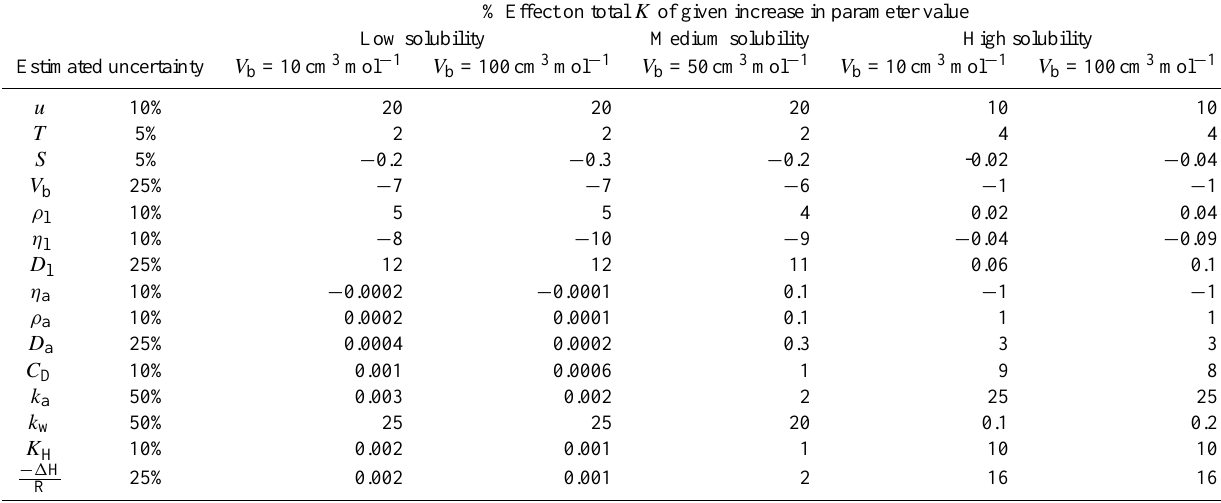
Table 5. Analysis of the sensitivity of total transfer velocity ( K ) to changes in the values of key components of the scheme. Note that the estimated uncertainty is intended to represent maximum likely uncertainty in estimation of parameter values from, e.g., model output (for temperature, salinity and wind speed) and from the parameterizations/measurements used for the others. The sensitivity to a change of the same magnitude as the estimated uncertainty is tested. A negative sign denotes a decrease in K in response to an increase in the parameter value.